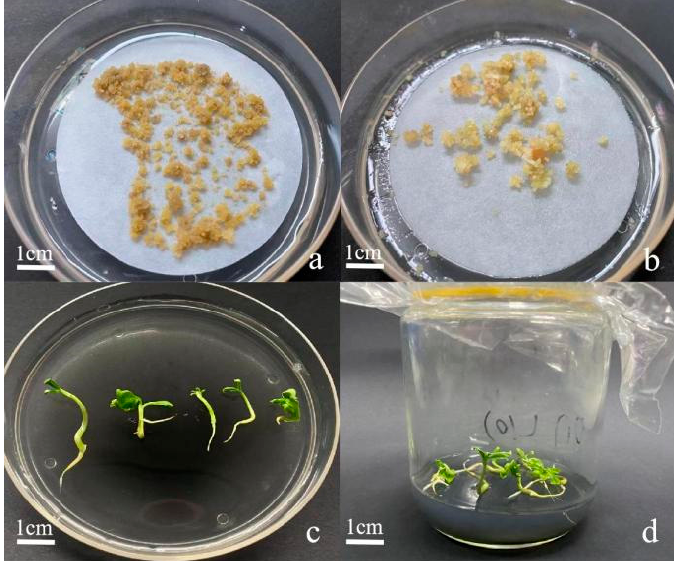
Figure 7. The process of recovery culture after cryopreservation of F. mandshurica EC by the vitrifi- cation method: ( a ) the 60th day of recovery of F. mandshurica EC; ( b ) callus-differentiated somatic embryo; ( c ) F. mandshurica buds generated from somatic embryo; ( d ) Emblings of F. mandshurica . bar = 1 cm.